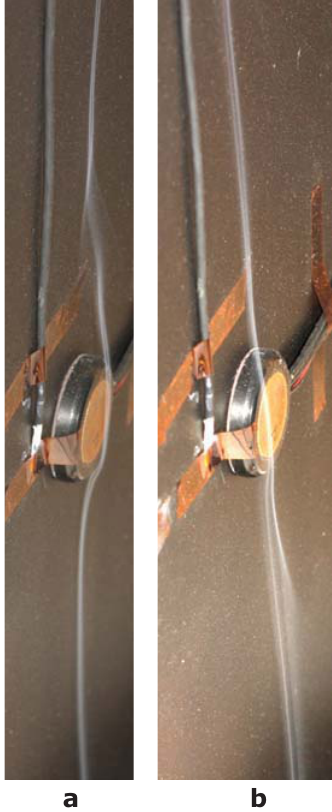
Figure 4: Free convection over heated vertical plate, Ra